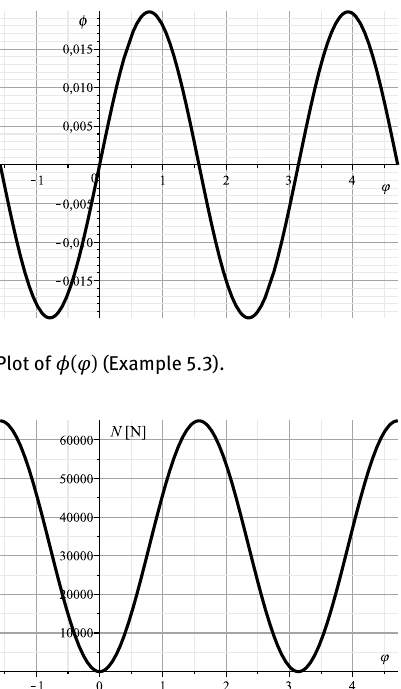
Figure 30: Plot of σ φ as a function of r for φ i ( i = 5 . . . 7) (Example